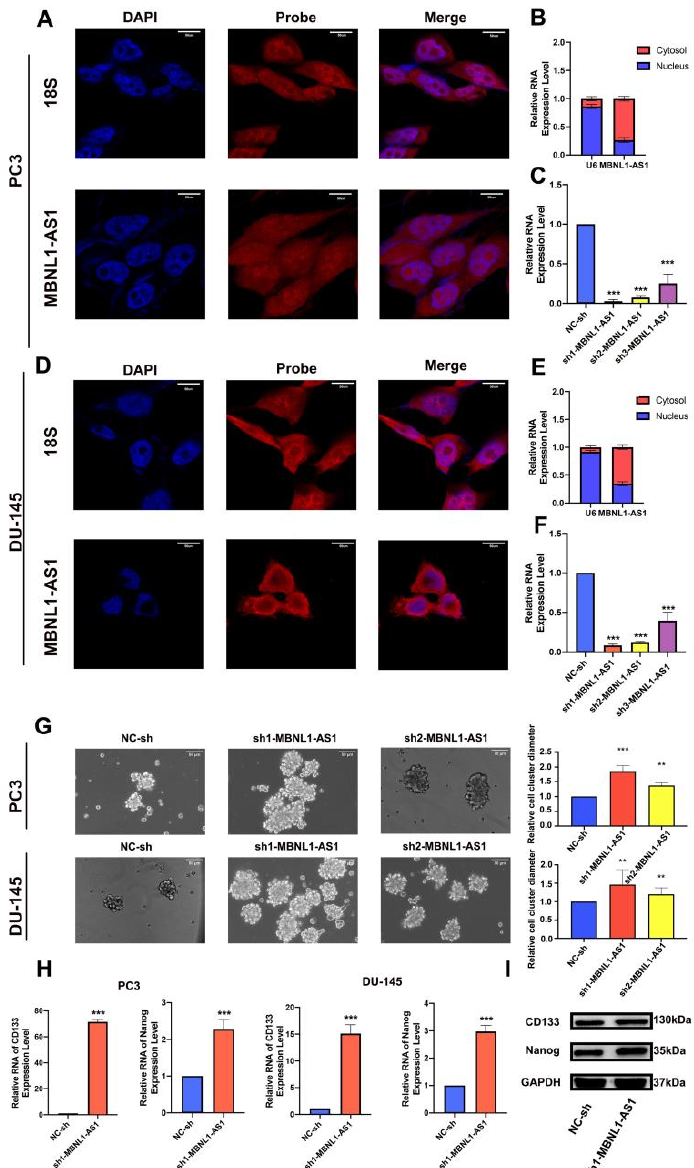
Figure 3. Subcellular localization of MBNL1-AS1 and its target genes, and examination of the effects of the target genes on stem cell function. ( A – F ) MBNL1-AS1 subcellular localization was confirmed by FISH and nucleoplasmic separation assays and sh-MBNL1-AS1 was transfected into PC3 and DU-145 cell lines, and the knockdown efficiency was determined by qPCR. ( G ) The sphere formation assay was used to examine the effect of MBNL1-AS1 knockdown on PCSC function. mRNA ( H ) and protein ( I ) expression levels of markers of stemness. ** p -value < 0.01; *** p -value < 0.001.